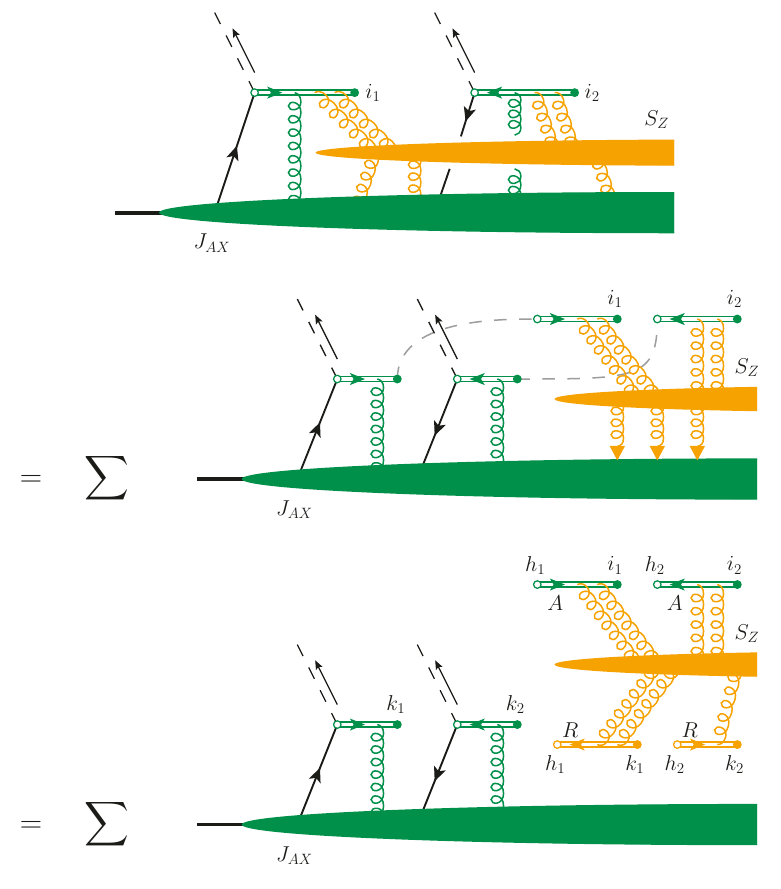
Figure 13 . Decoupling of soft gluons from the unsubtracted collinear matrix element J AX; unsub de(cid:12)ned in